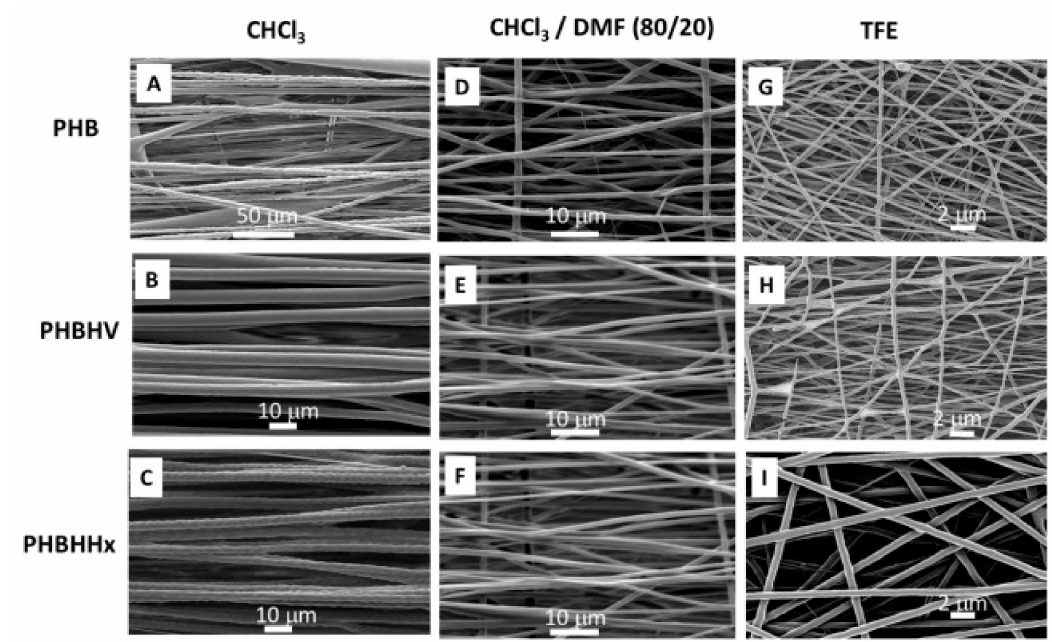
Figure 7. Scanning electron micrographs of electro-spun fibers of PHB 14% (wt/vol) in chloroform (CHCl 3 ) ( A ), PHBV 30% (wt/vol) in CHCl 3 ( B ), PHBHHx 10% (wt/vol) in CHCl 3 ( C ), PHB 14% (wt/vol) in CHCl 3 /dimethylformamide (DMF) ( D ), PHBV 25% (wt/vol) in CHCl 3 /DMF ( E ), PHB- HHx 10% (wt/vol) in CHCl 3 /DMF ( F ), PHB 10% (wt/vol) in trifluoroethanol (TFE) ( G ), PHBV 15% (wt/vol) in TFE ( H ), PHBHHx 10% (wt/vol) in TFE ( I ). Reprinted from Grande et al. (2017) [166] with permission from